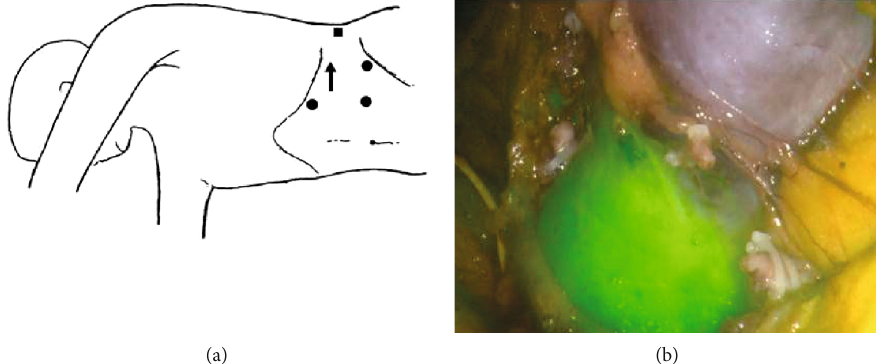
Figure 2: (a) The placement of the trocar port and an incision for removal of the extirpating organs. Black circle: operator ’ s port. Black triangle: camera port. Black square: assistant ’ s port. Black rectangle: six cm incision for removal of extirpating organs. (b) Interruption of blood fl ow is con fi rmed between the left moiety and the right moiety visualized by indocyanine green (ICG) fl uorescence system. The green region shows blood fl ow to the right